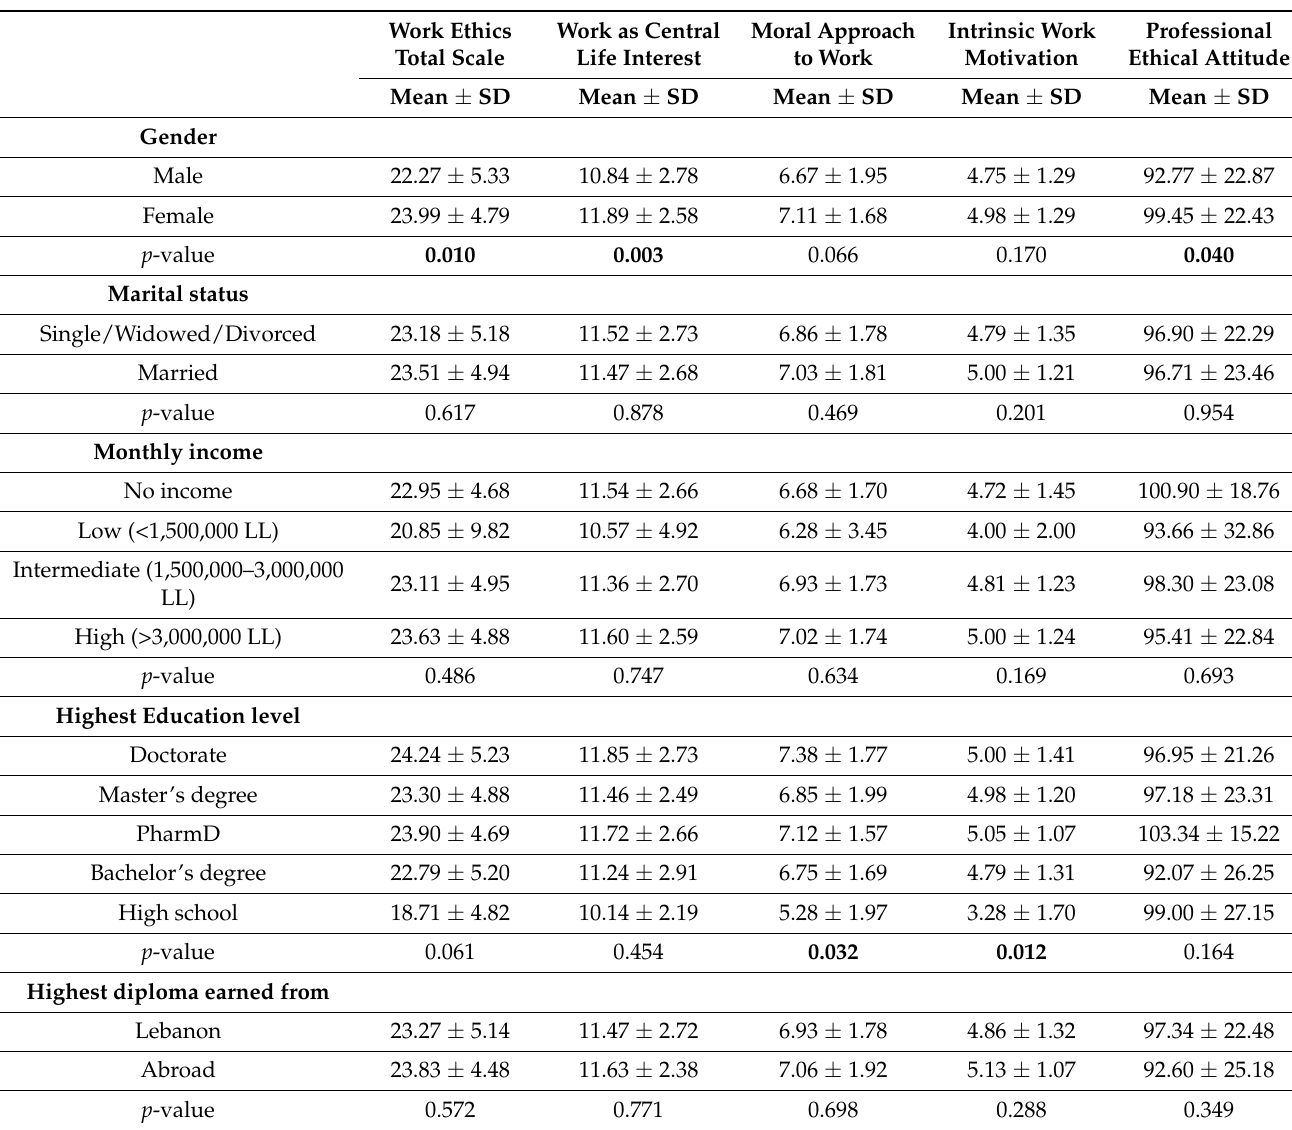
Table 3. Bivariate analysis taking the ethical scales and professional ethical attitude as the dependent